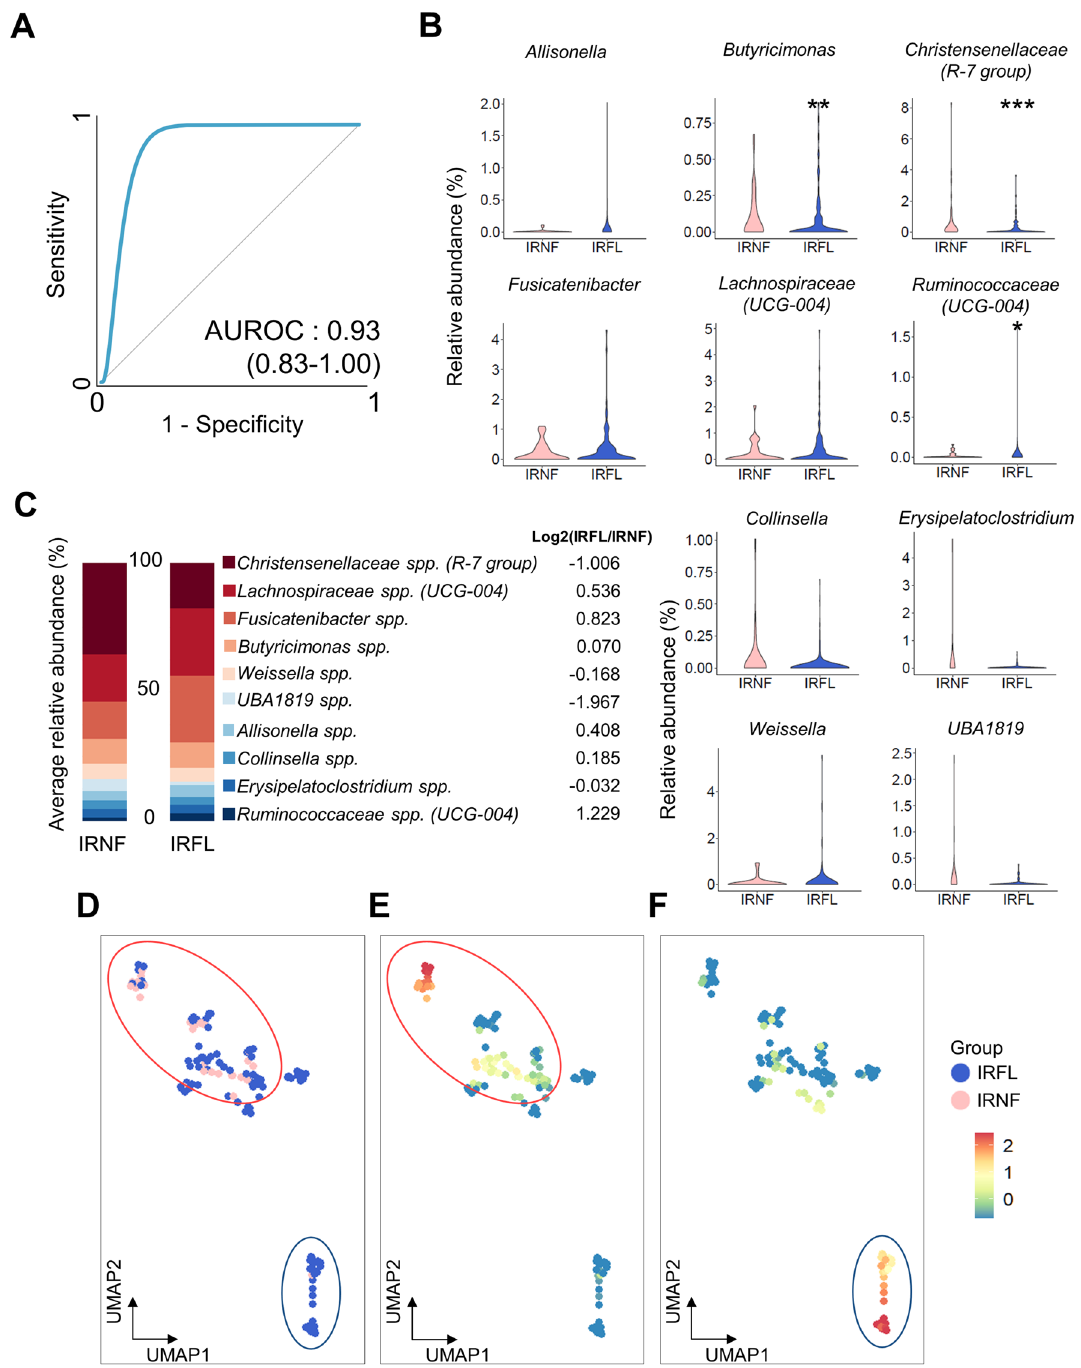
Figure 5. Prediction of FL in the presence of insulin resistance using GA-optimized classifier. ( A ) The predictive power (AUROC) derived from the test dataset using GA-optimized RF classifier with ten features. ( B ) Violin plots displaying relative abundances of core informative features in IRNF and IRFL. ( C ) Average relative abundances of discriminative features in the 10-feature prediction model in IRNF and IRFL. ( D – F ) UMAP analysis and heatmap of Christensenellaceae (R-7 group) spp. ( E ) and Lachnospiraceae (UCG-004) spp. onto UMAP. * p < 0.05, ** p < 0.01, and *** p < 0.001 (Wilcoxon’s test). IRFL: fatty liver participants featuring insulin resistance; IRNF: nonfatty liver control group featuring insulin resistance; UMAP: uniform manifold approximation and